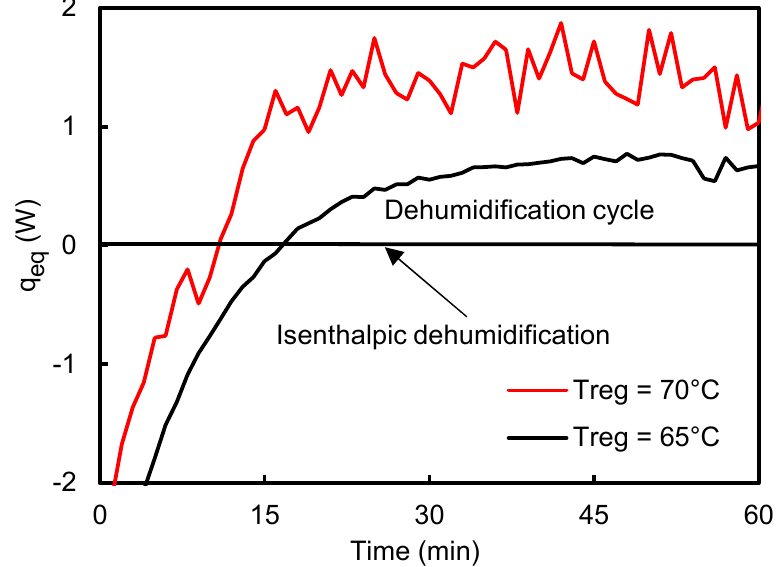
Figure 4. Impact on the amount of equivalent heat of adsorption at di ff erent regeneration temperatures.